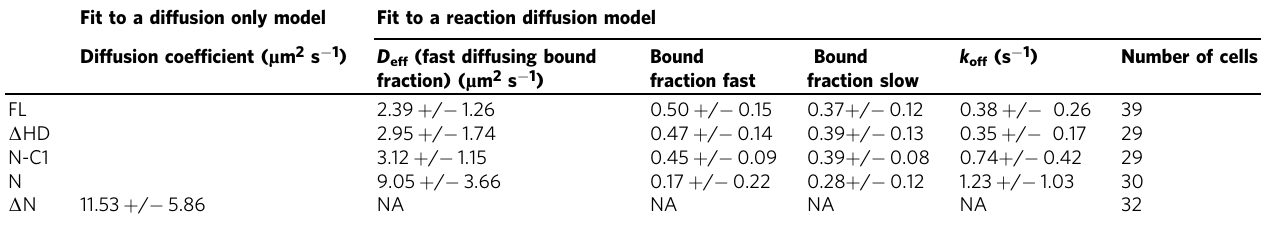
Table 1 Estimates of spatiotemporal FRAP fi t parameters for VL3-3M2 Fit to a diffusion only model